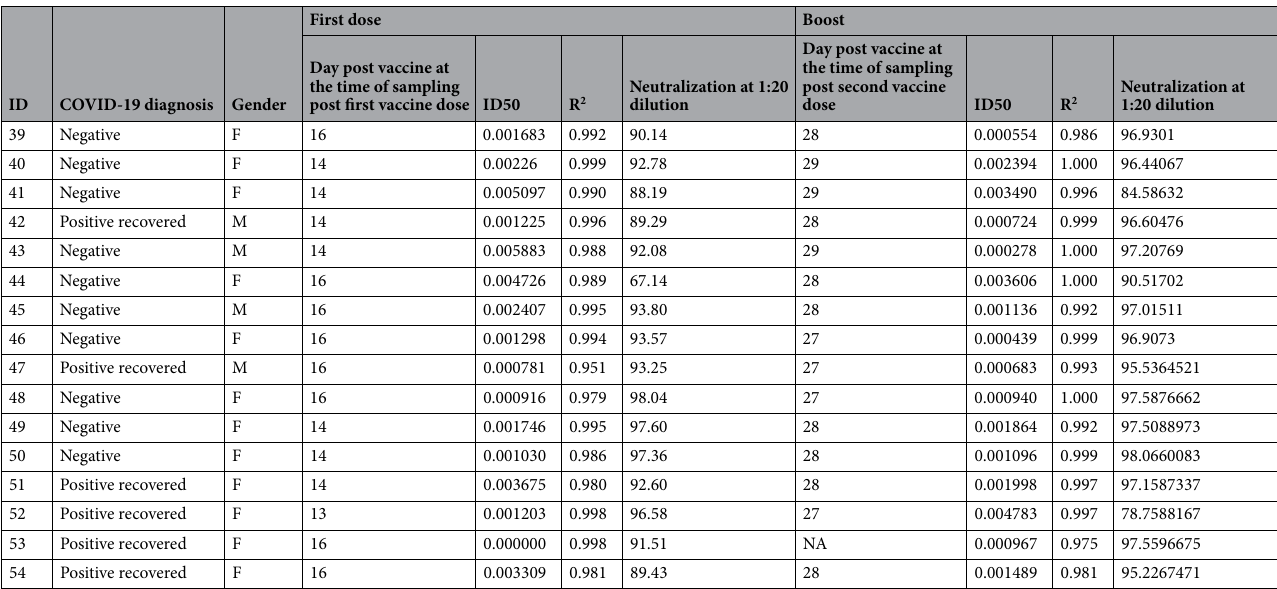
Table 2. Clinical and neutralization information from BNT162b2 vaccinated individuals. NA Unavailable information.